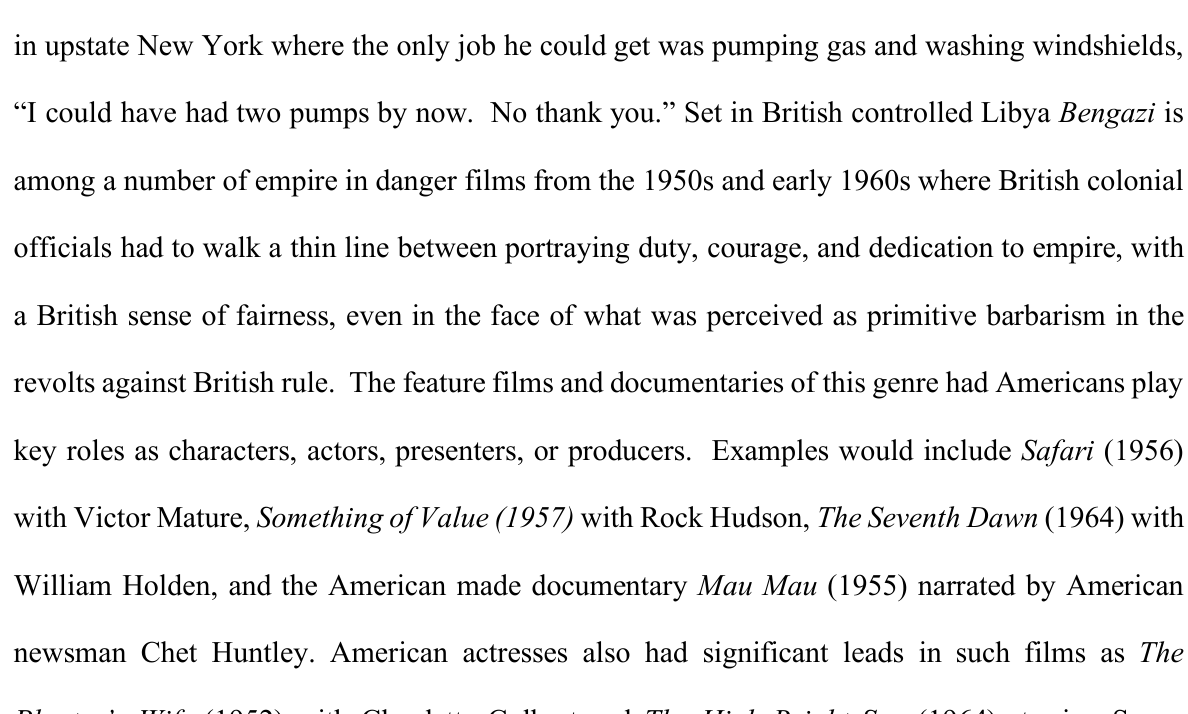
CINEJ Cinema Journal: The Black Tent (1956) and Bengazi (1955): The Image of Arabs in Two Post-Empire Journeys into the Deserts of